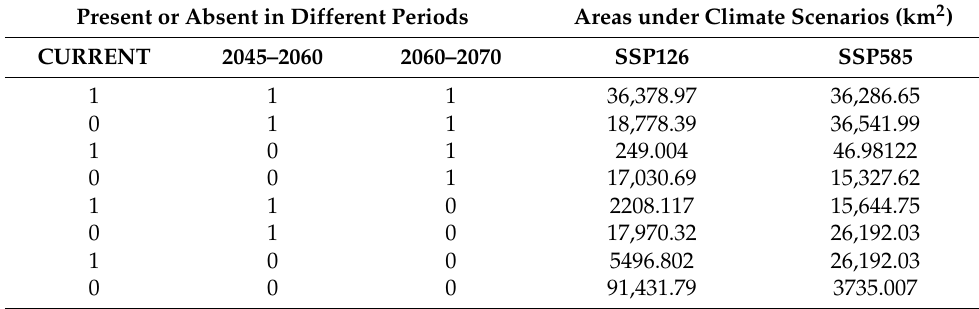
Table 3. Changes to suitable areas under climate change: 0 refers to an absence of the species, and 1 refers to its